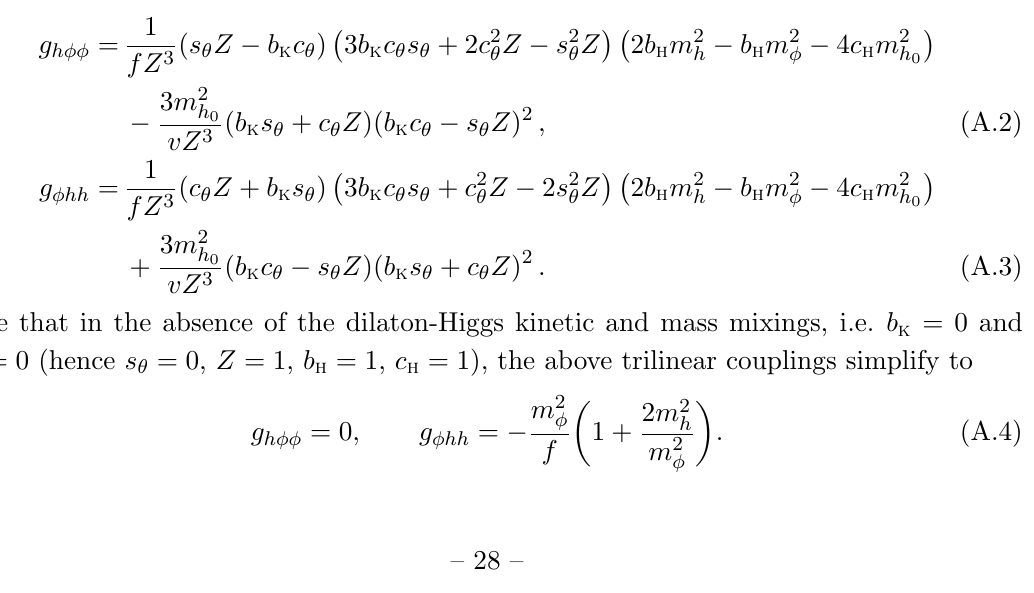
Table 3 . Feynman rules for the SM-like Higgs h and the dilaton (cid:30) couplings with the SM particles. The triangle loop functions F s and A s are collected below where the subscript denote the spin of the particle in the loop and the sum over all the particles in the corresponding loops is understood. The model dependent coe(cid:14)cients b ’s and c ’s can be found in table 1. After applying the rotational matrix (2.5), in the physical mass eigenbasis ( (cid:30); h ), these trilinear couplings have the form,